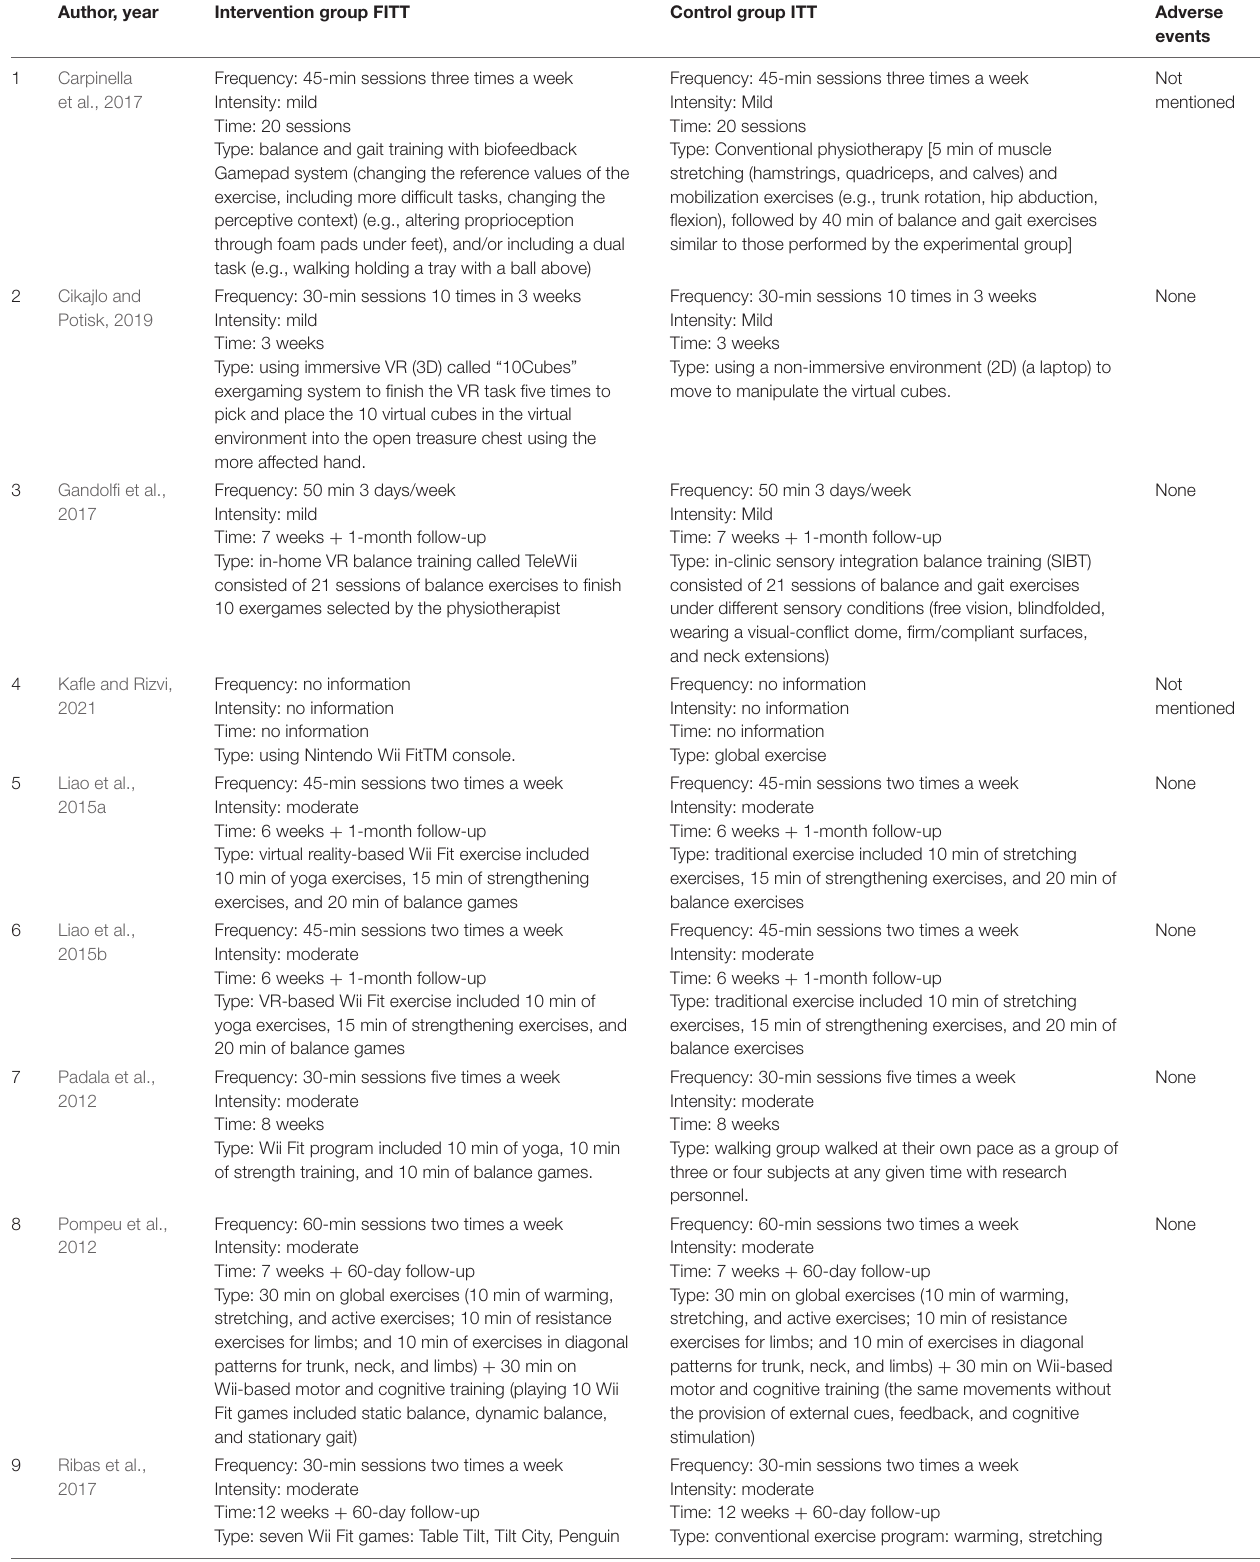
TABLE 3 | Interventions in the included